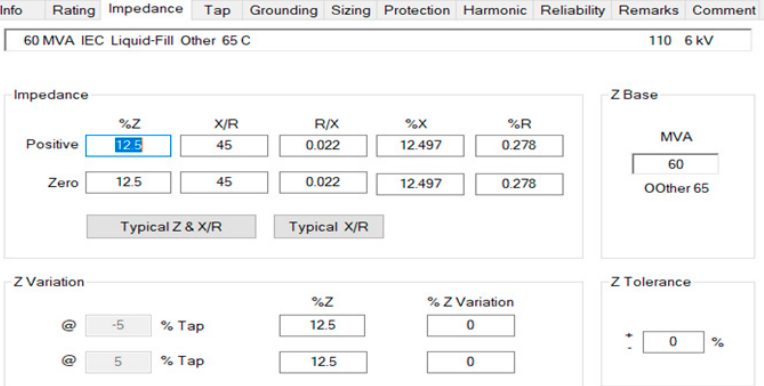
Figure 6. Percent impedance values for T1.